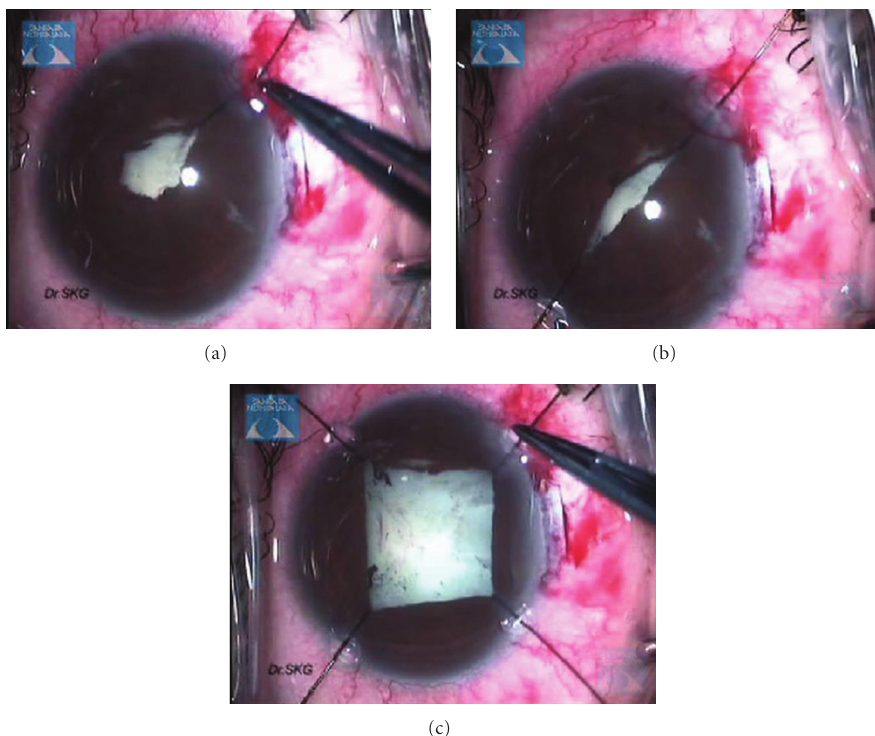
Figure 6: Intraoperative use of self-retaining iris hooks to dilate the pupils.